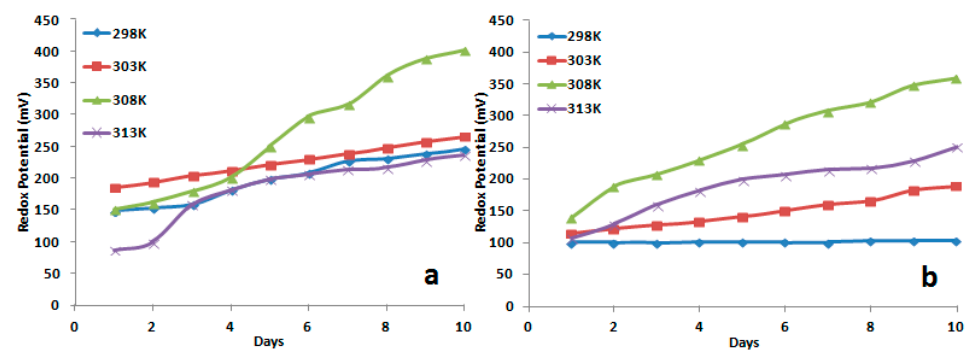
Figure 9. Variation of redox potential during bio-leaching of PCB at different temperatures using 8% pulp density at pH 2.0 in 10 d [( a ) bacterial leaching; ( b ) fungal leaching]. Table 2. Optimal Cu bioleaching performance obtained in the present study using desktop shredded PCBs. Microbes Particle Pulp Temp Duration % Cu Composition of PCBs Additive pH Used Size Density (K) (h) Extraction 3.88% Cu, 0.169% Ni, 0.368% Co, 2.3% Fe, 1.92% Al, 0.021% W, 0.006%